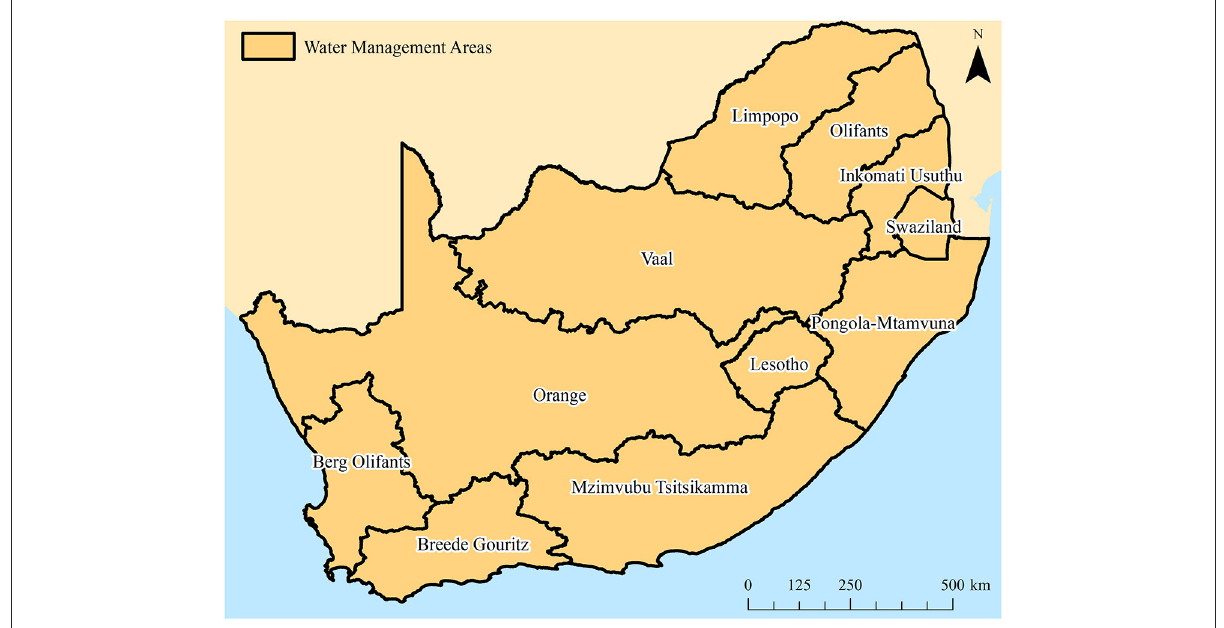
FIGURE3 Water management areas in South Africa, with which each Catchment Management Area (CMA) would